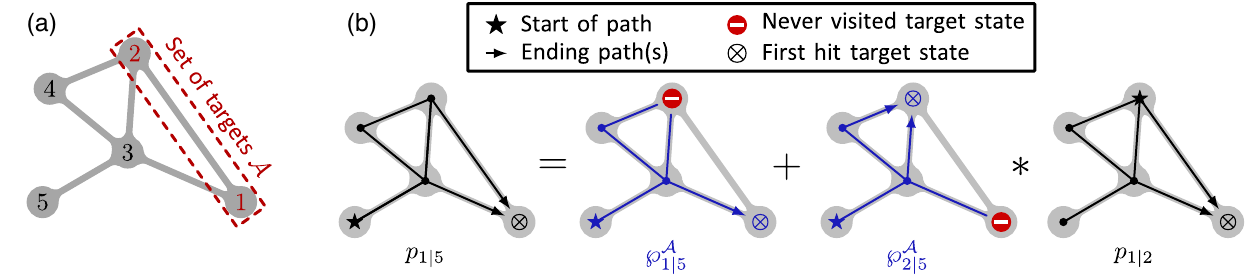
FIG. 9. Illustration of generalized renewal theorem. (a) Network with five states Ω ¼ f 1 ; 2 ; 3 ; 4 ; 5 g . The dashed box encloses one set of target state A , which is here chosen to be A ¼ f 1 ; 2 g . The network corresponds to the subnetwork from Fig. 1(e) in the main text (see also Fig. 3 therein). (b) Path decomposition according to generalized renewal theorem from Eq. (C2) or equivalently Eq. (C3) for the special case of two target states A ¼ f 1 ; 2 g with a ¼ 1 . Each arrow tip corresponds to a path ending at the particular state without having visited that state before; each filled dot is a state that may have been